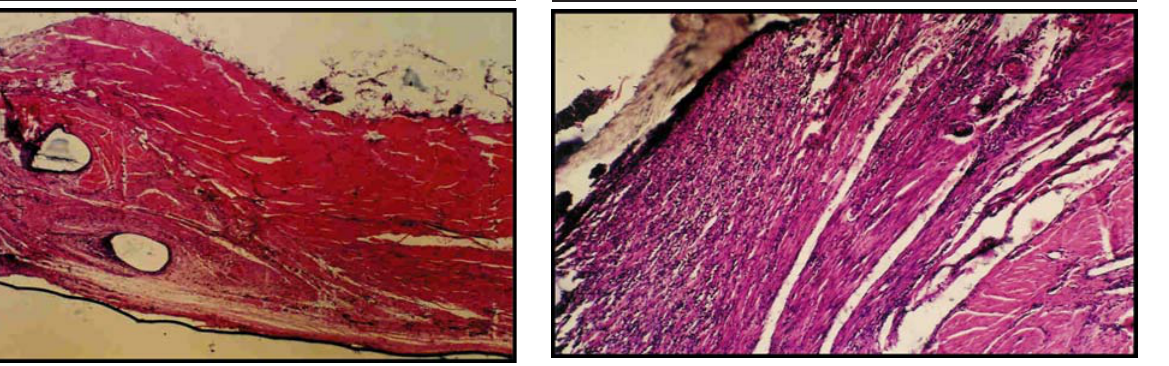
FIGURE 5 - Photomicrography of histological cut of animal in cohort E-A, showing part of the mesh and granulation tissue formed along the muscle of the abdominal wall of the rat